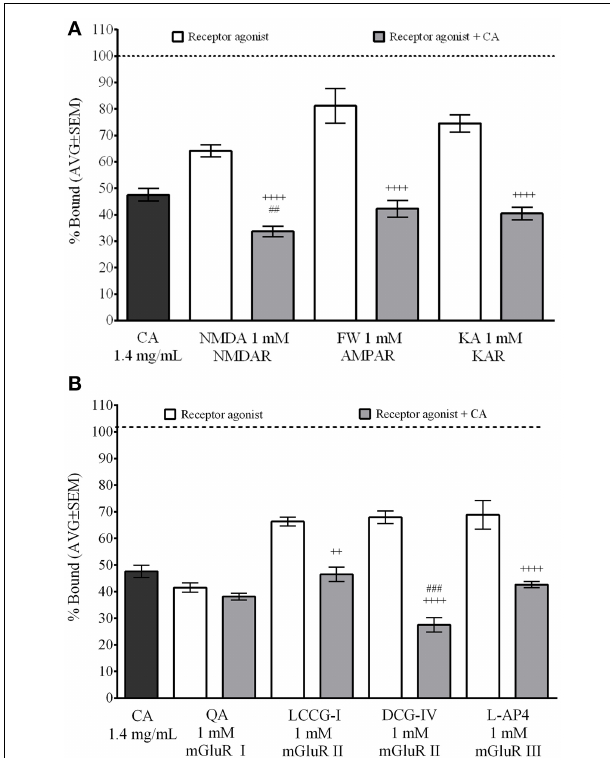
FIGURE 5 | Selective In vivo interaction of C. aurantium extract with iGluR. Fish were allowed 1h absorption of various concentrations of selective iGluR antagonist D-AP5 (NMDAR), NBQX (AMPA), UBP 301 (KAR) followed by 1h absorption on C. aurantium extract at 28mg/mL prior exposure to PTZ 3mg/mL. (A) D-AP5 2.7 and 6 μ M prior exposures to C. aurantium extract significantly reduced seizure latency when compared to C. aurantium alone. (B) Exposure to NBQX prior exposures to C. aurantium extract showed a tendency to reduce seizure latency when compared to C. aurantium alone. (C) Exposure to UBP 301 prior exposures to C. aurantium extract had no significant effect on seizure latency when compared to C. aurantium alone. Results are shown as average ± SEM of at least three experiments, n > 12. ∗∗∗∗ vs. Naive P < 0 . 0001, ## vs. C.